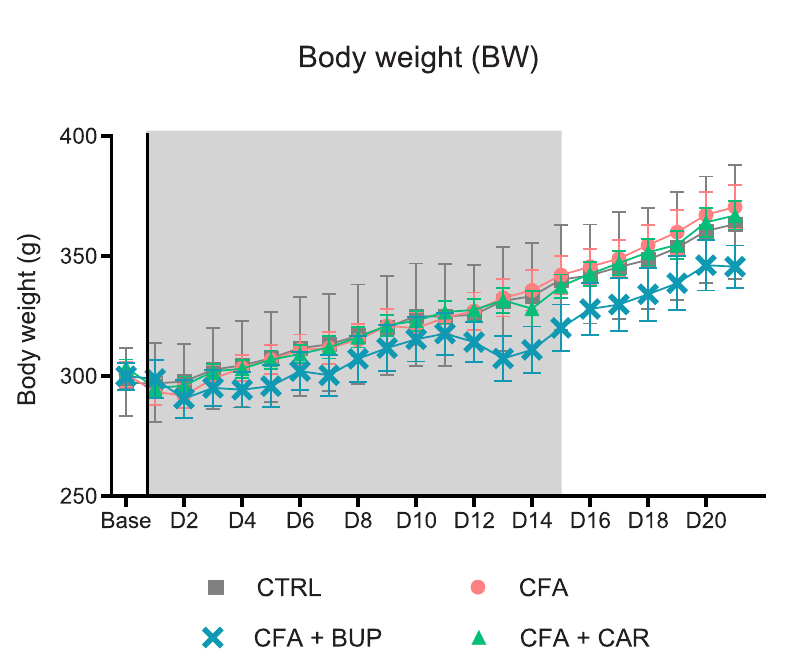
Fig 2. Body weight (BW). Mean body weight per group on day 1–22 and baseline values. Data were analysed by a two- way RM ANOVA followed by Tukey’s multiple comparisons tests. The line represents the day of analgesic treatment initiation (D0) and the grey area represents the days with treatment administrated. Values are expressed as mean ± SEM. For all graphs: base = baseline values, D = day, the line represents the day of analgesic treatment initiation (D0) and the grey area represents the treatment period (15 days). All groups: n = 8, male Sprague Dawley rats.